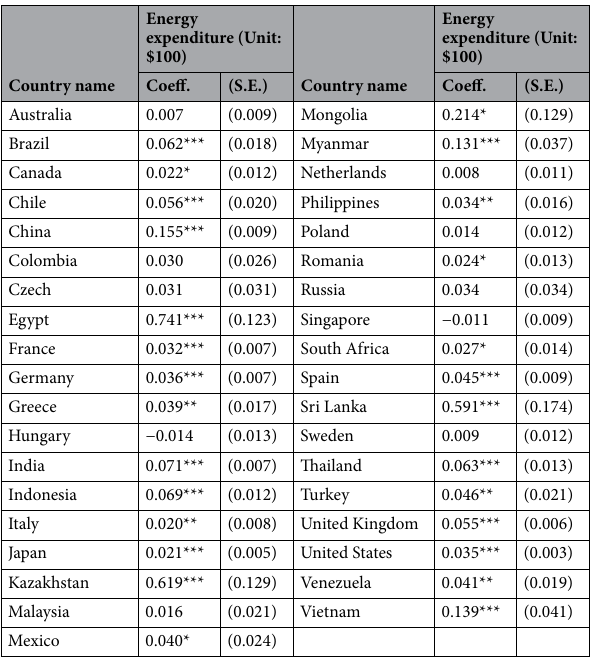
Table 3. Relationship between energy expenditure and life satisfaction for each country. Standard errors are shown in parentheses. *** p < 0.01, ** p < 0.05, * p <